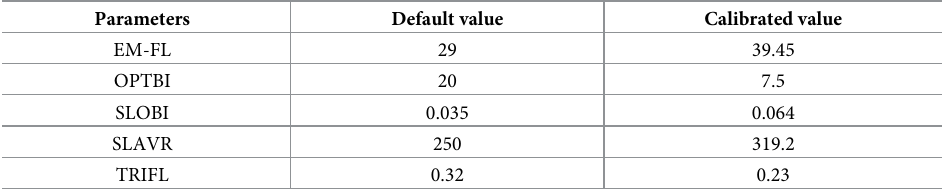
Table 7. Calibrated cultivar coefficients for the most sensitive